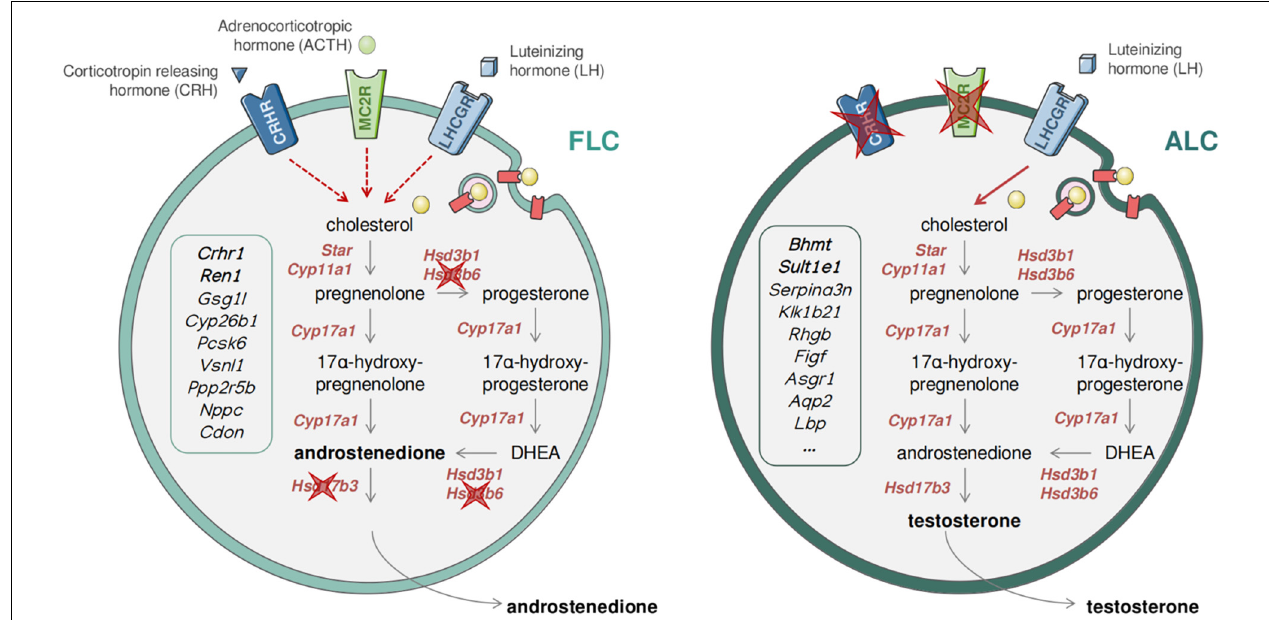
FIGURE 6 | Dual and sequential model of steroidogenesis regulation. Drawing recapitulating the similarities and differences between FLCs (Left) and ALCs (Right) . The expression of the ACTH receptor (encoded by Mc2r ) and the CRH receptor (encoded by Crhr1 ) in FLCs suggests that the regulation of androgen production is mediated by LH, CRH, and CRH, while in the absence of CRH and ACTH receptors in ALCs the regulation is exclusively under the control of LH.